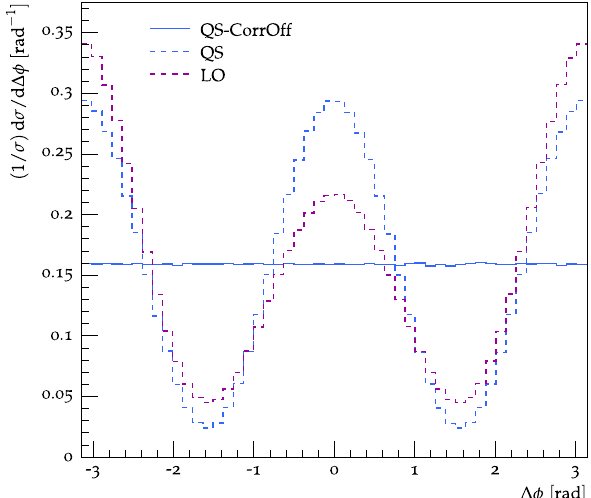
Fig. 3 Theanalyticresultforthedifferenceinazimuthalanglebetween theplanesofthetwobranchingsin h 0 → gg → q ¯ qq (cid:3) ¯ q (cid:3) comparedtothe distributions predicted using the angular-ordered (QS) and dipole (DS) partonshowersin Herwig 7.Theangular-orderedshower(QS-CorrOff) and dipole shower (DS-CorrOff) predictions without spin correlations are included for comparison. The result obtained from a sample of LO events generated using MadGraph5_aMC@NLO (LO) is also shown